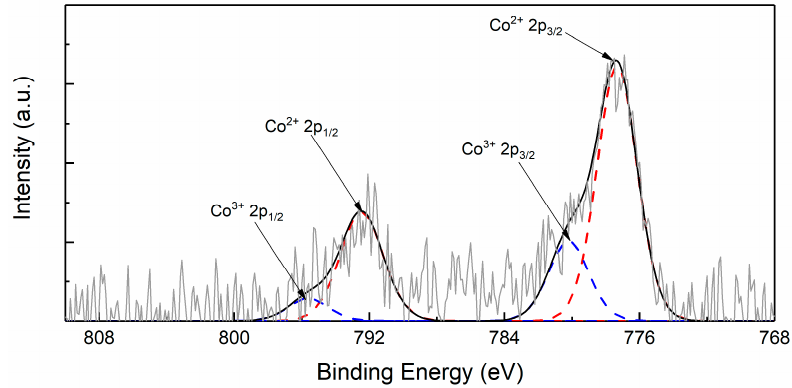
Figure 3. XPS of LiCoO 2 after 150 charging-discharging cycles under 4.2 V.